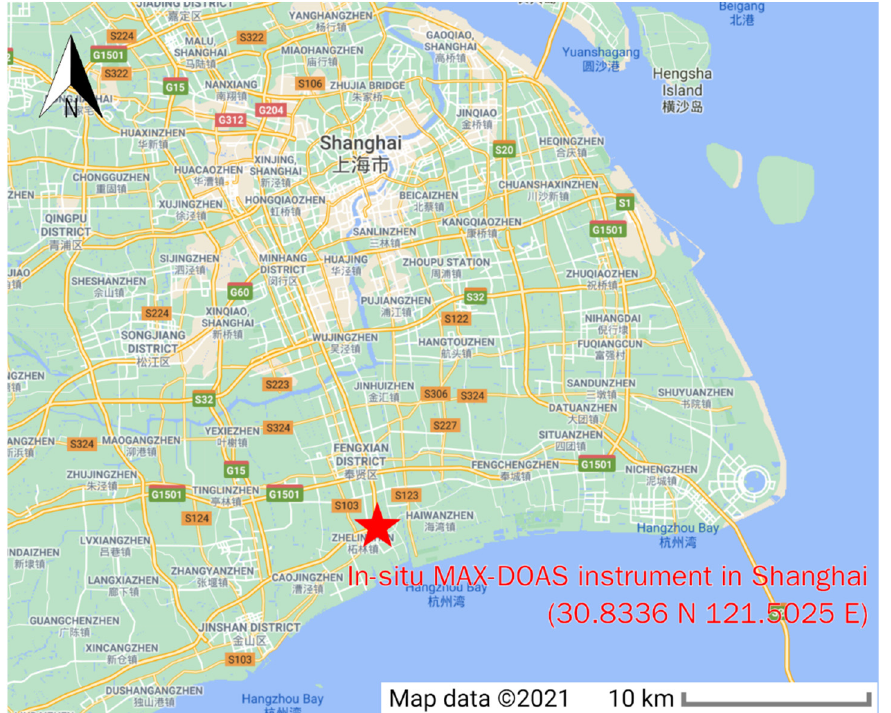
Figure 1. The position of the MAX-DOAS observation sites in Shanghai. The instrument was set up on the roof of the Environmental Science Building in the Fengxian campus of East China University of Science and Technology (30.8336°N 121.5025°E). Figure 1 was captured from online Google Map.